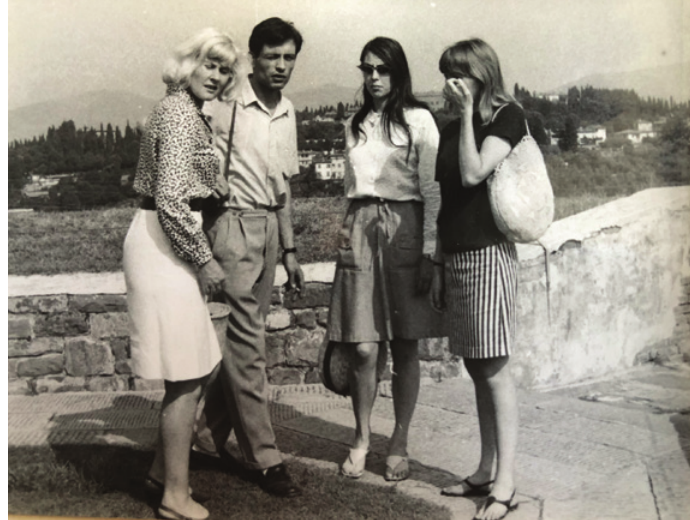
Figure 2 At Forte di Belvedere in 1968. From left to right: Jo Rutter, Giorgio Tolone, Marion Bacon and Louise Bacon. (Image credit: